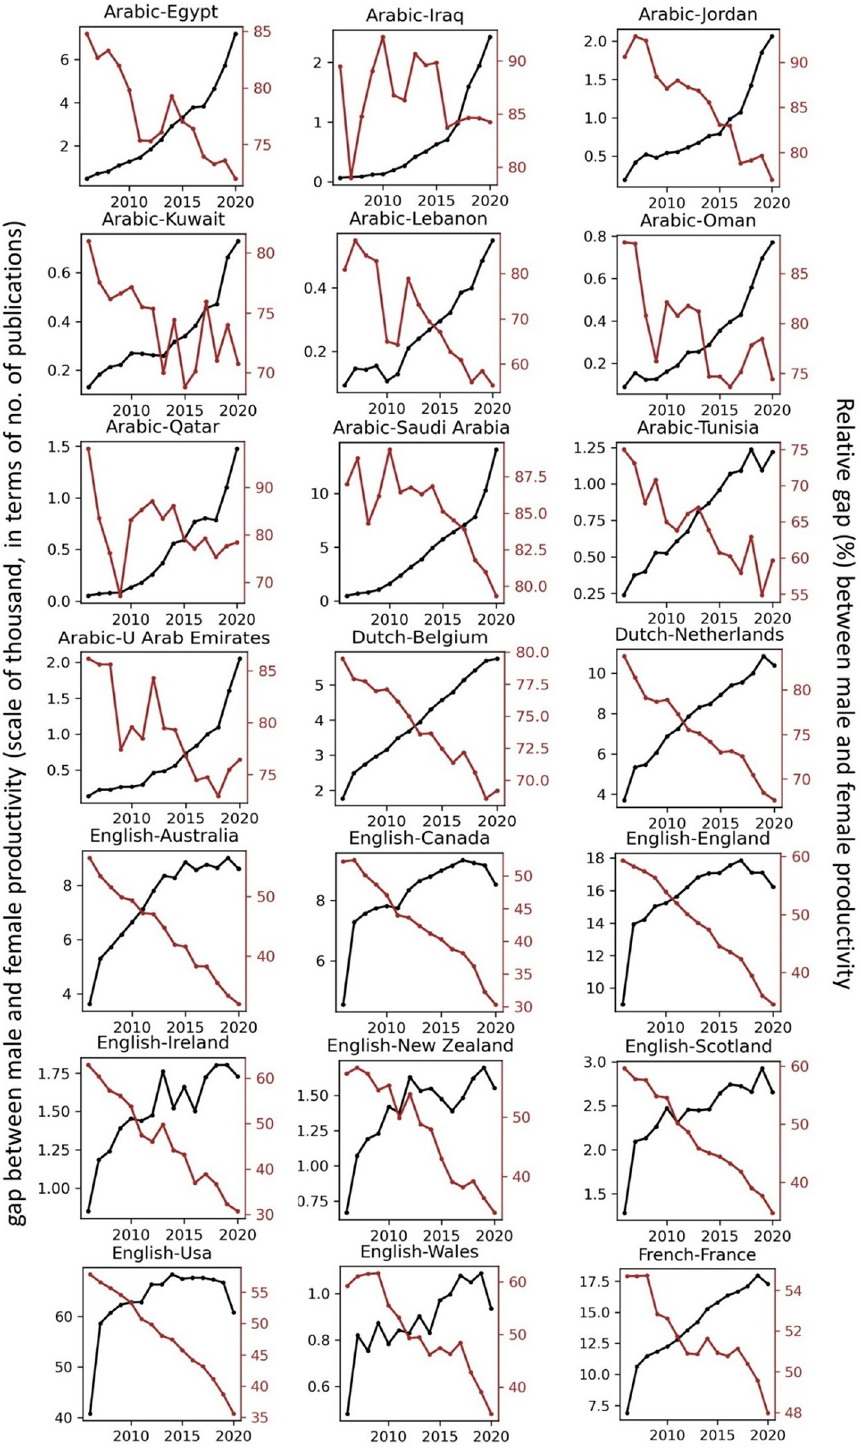
Fig 11. Gaps between male and female total research productivity, A-C method (part 1).